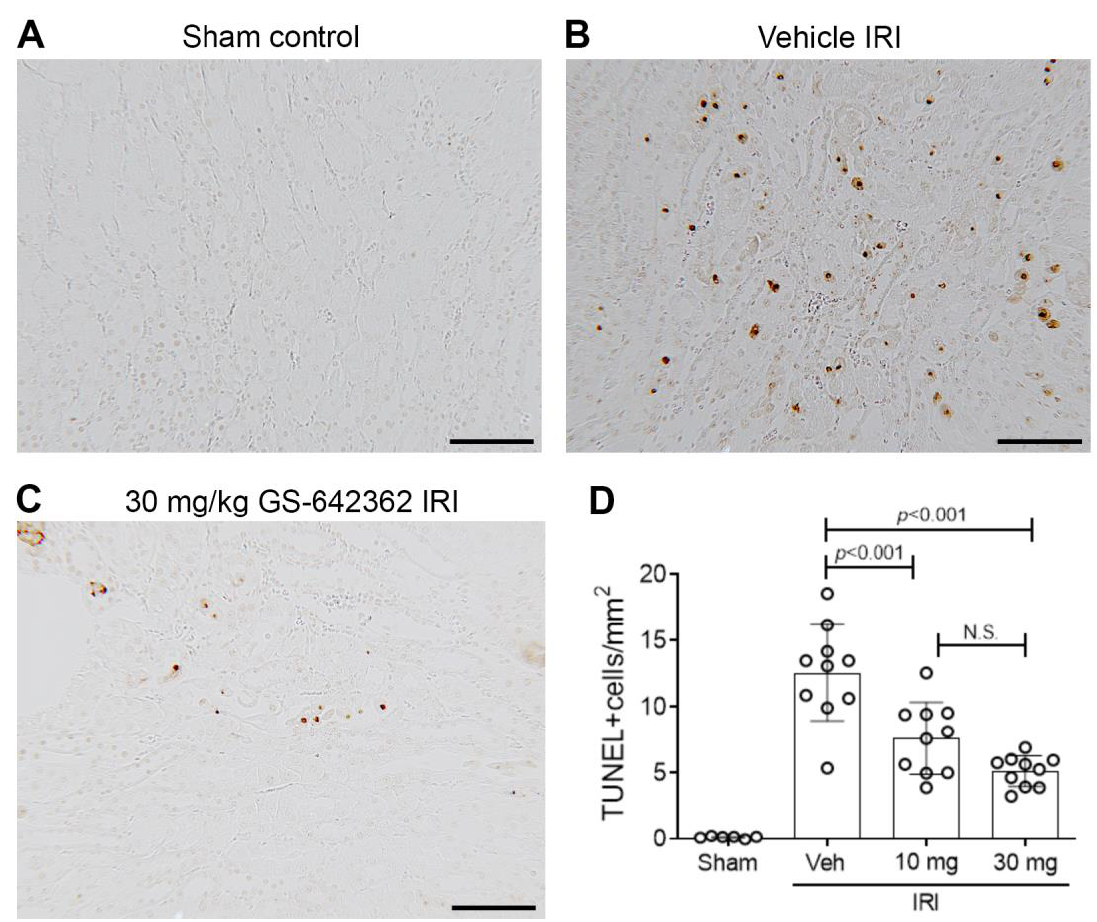
Figure 3. Cell death in renal ischemia/reperfusion injury (IRI). Groups of mice (n = 10) were treated with vehicle, 10 or 30 mg/kg/BID GS-642462 and compared to sham controls (n = 6). ( A – C ) TUNEL staining. ( A ) Sham control lacks TUNEL+ cells. ( B ) Vehicle-treated IRI showing many TUNEL+ tubular cells in the outer medulla. ( C ) IRI treated with 30 mg/kg GS-642362 shows a marked reduction in the number of TUNEL+ cells. Bar = 100 µm. ( D ) Graph of TUNEL+ cells.